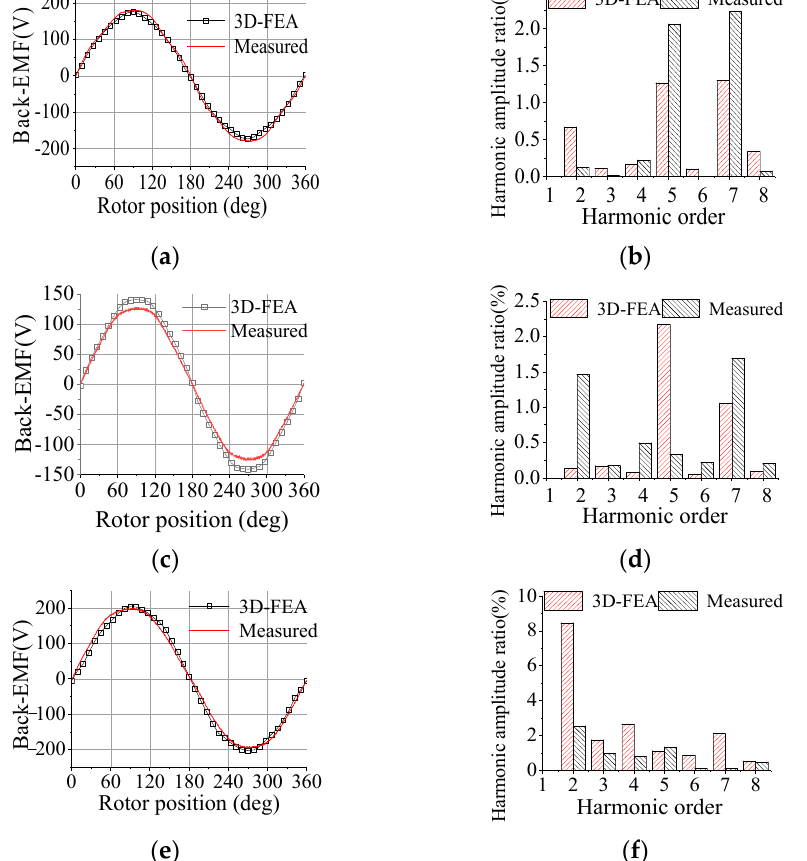
Figure 22. Back-EMF waveforms for the two types of machines. ( a , b ) AMC-FRPM machine. ( c , d ) AMA-FRPM machine. ( e , f ) FRPM machine.